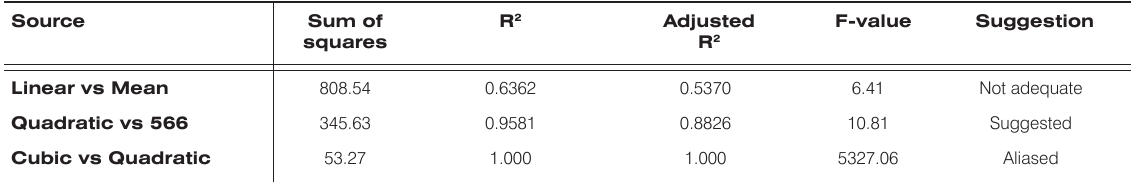
Table 2. Statistical summary for each model.